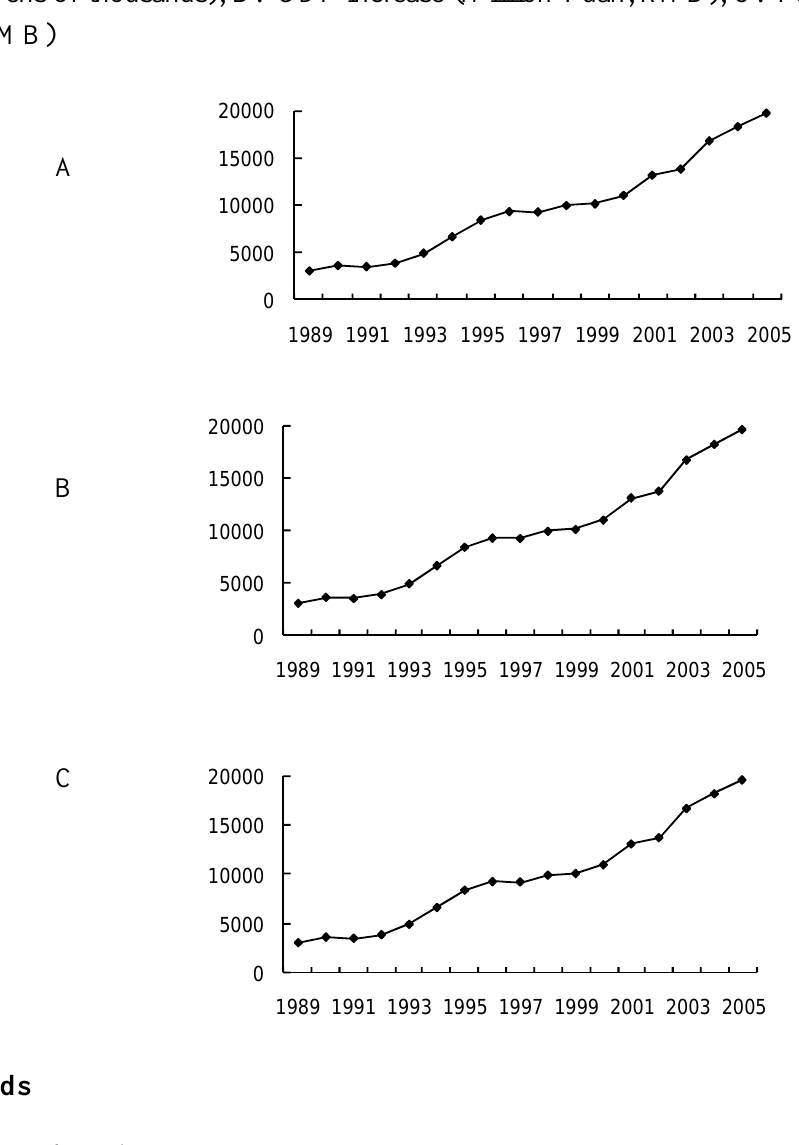
Figure 2. Major social economic indicators in the study area. A: Population